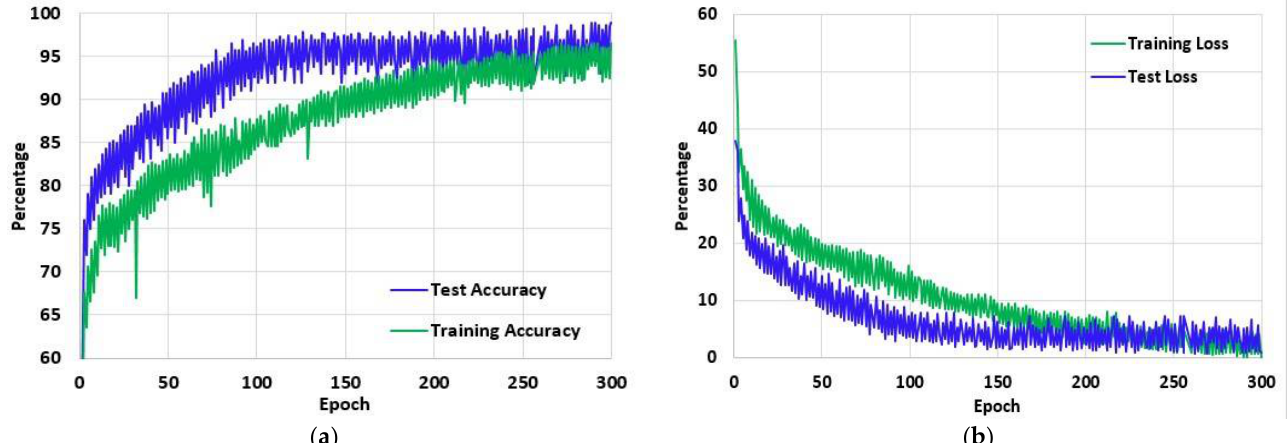
Figure 11. The ( a ) Accuracy and ( b ) Loss of the proposed model LungNet22 for 300 epochs using ‘Adam’ optimizer with learning rate 0.000001.